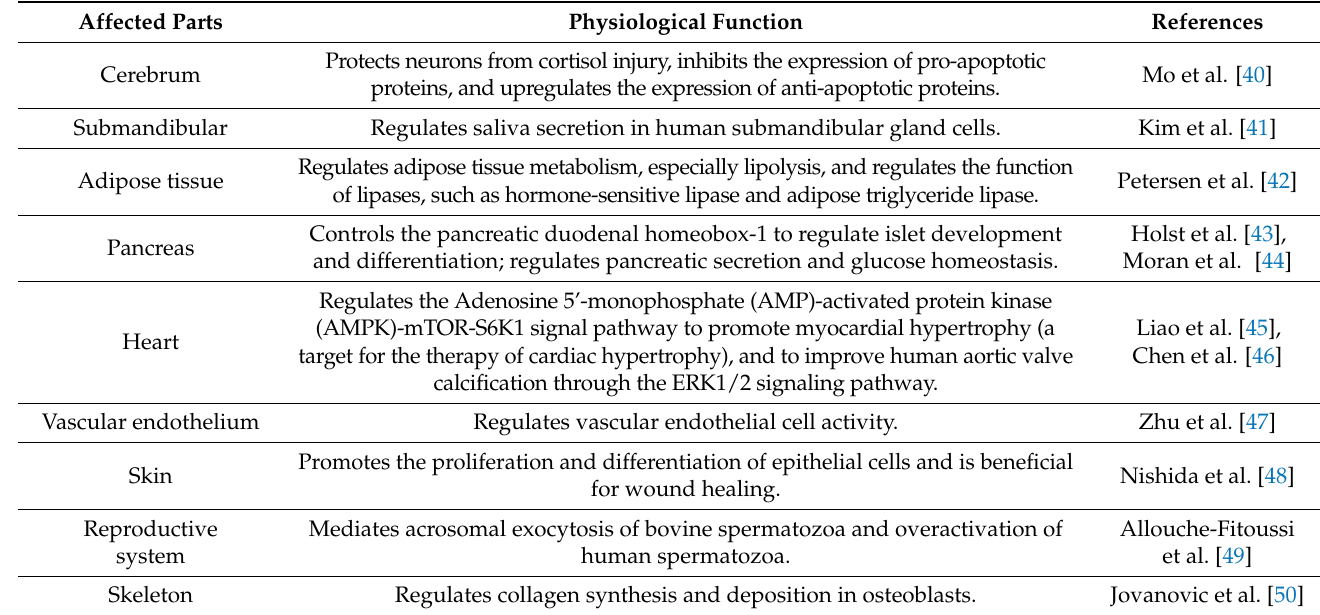
Table 1. Physiological function of GPR39 in the body. Physiological